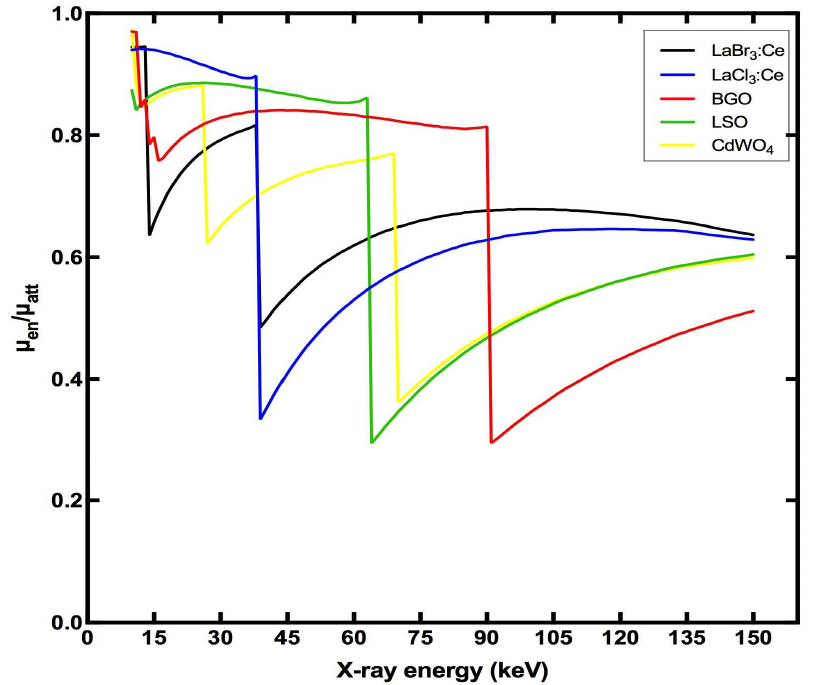
Figure 4. The ratio μ en /μ att of the LaBr 3 :Ce, LaCl 3 :Ce, BGO, LSO and CdWO 4 single crystals.